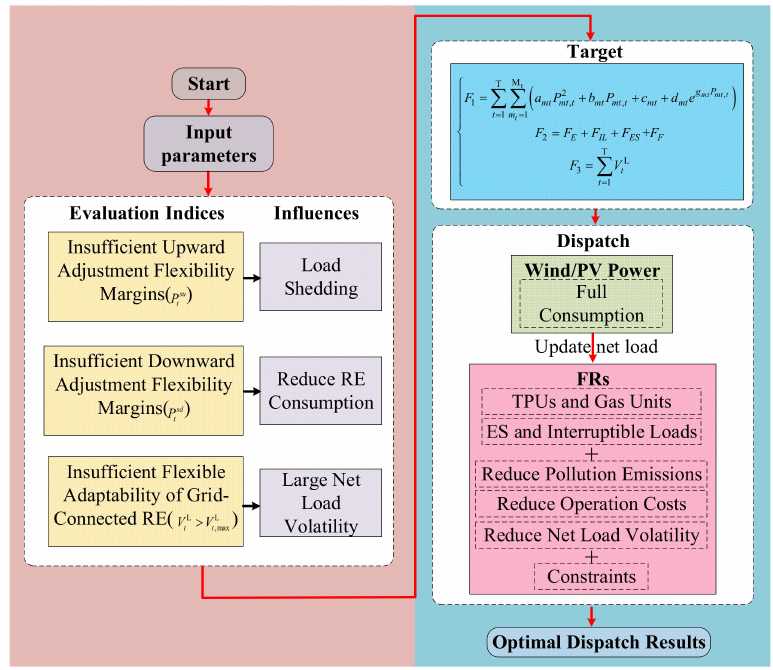
Figure 3. The overall flow chart of the proposed framework of optimal